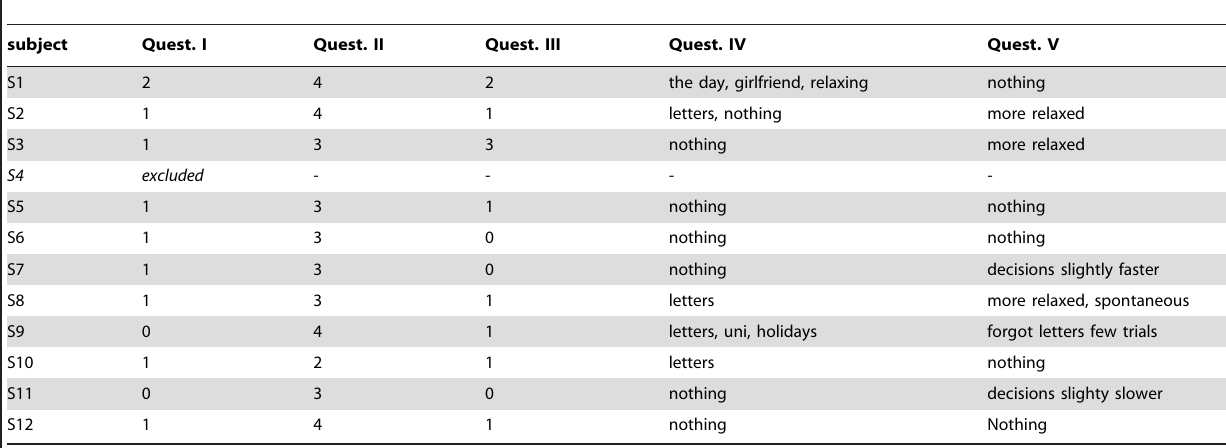
Table 2. Individual post-experimental interview